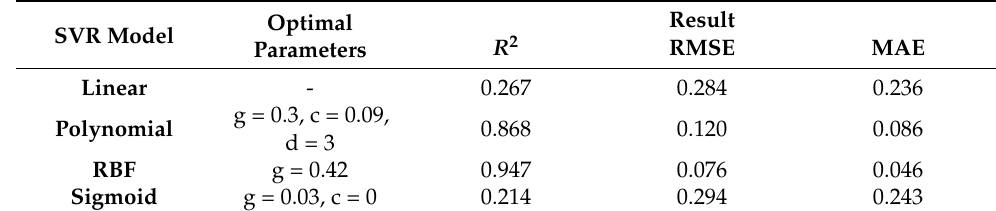
Table 5. Results of various models for simulation of FOS.